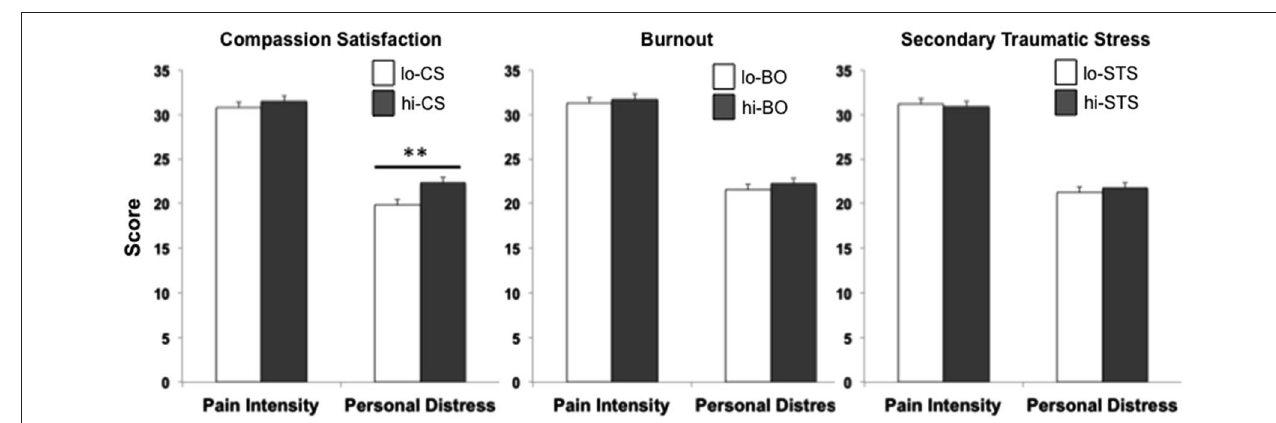
FIGURE 3 | The effect of professional quality of life . Comparison of lo- (white bar) and hi- (dark gray bar) participants for the three domains of professional quality of life. A significantly higher induced personal distress was found for hi-CS relative to lo-CS (* p < 0.01). Error bars are S.E.M .